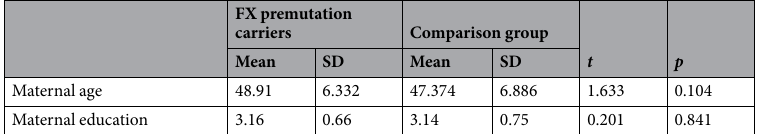
Table 1. Participants’ information and results of independent two-sample t-test. Demographic information and comparison for all participants in this study. Maternal education scaled as follows: 1: Less than high school; 2: High school graduate; 3: Some college/Bachelor’s degree; and, 4 Post bachelor’s/grad